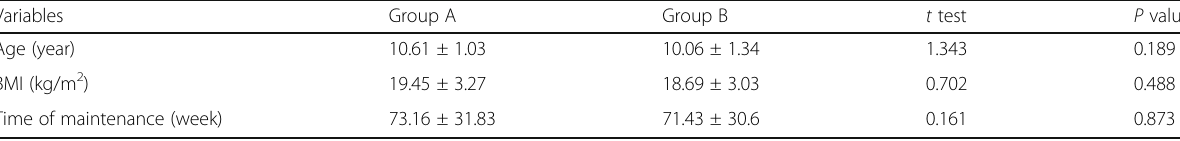
Table 2 Demographic characteristics of the patients in both groups